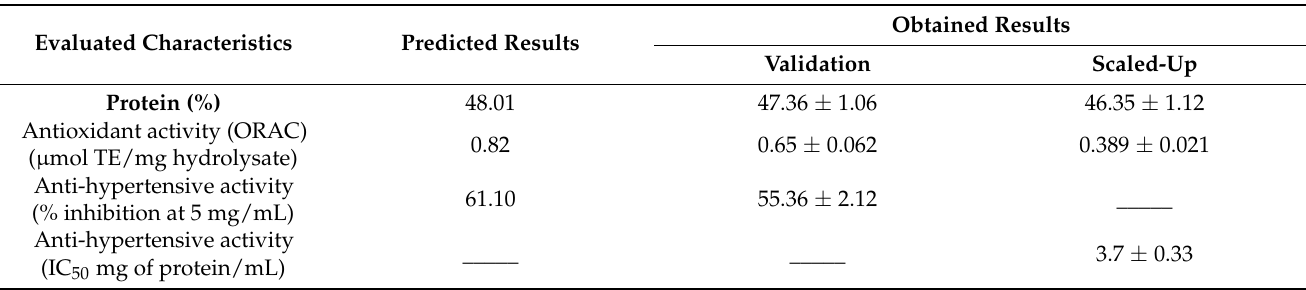
Table 12. Results predicted by the model, and results obtained in a validation and scaled-up enzymatic hydrolysis, performed with the optimal conditions described in Table